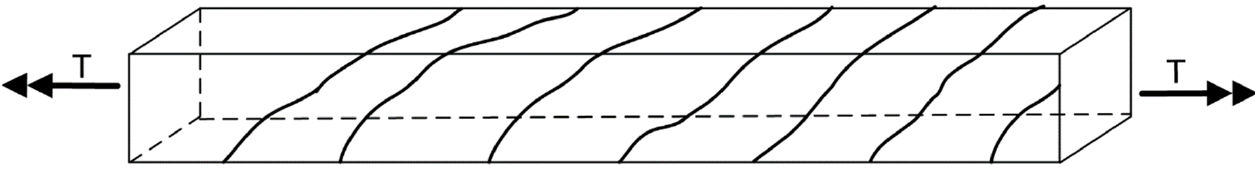
Figure 8. Macrocracks due to torsion; T —torsional moment.